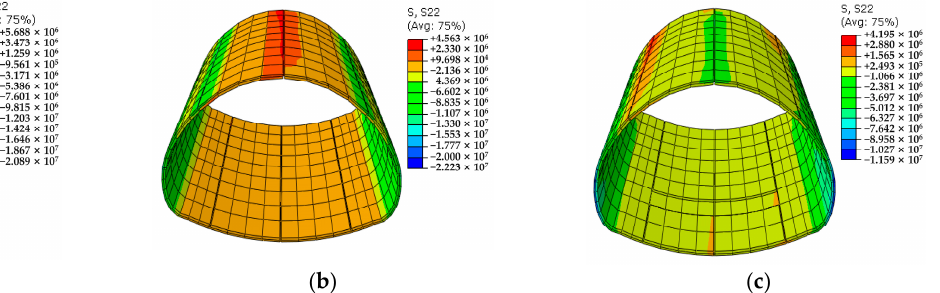
Figure 11. The vertical stress of the primary support in different conditions (unit: Pa): ( a ) Condition 1; ( b ) Condition 2; and ( c ) Condition 3.